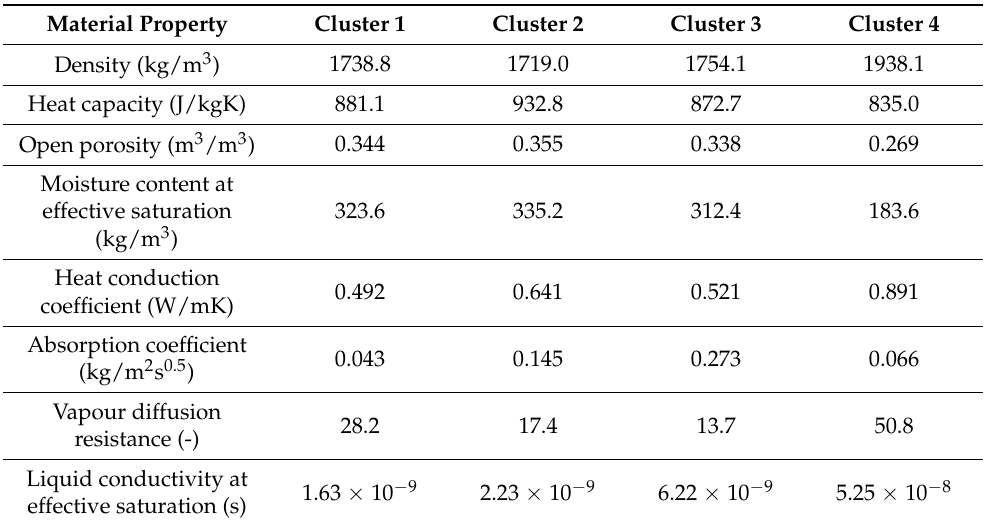
Table 2. Material properties of the 4 brick